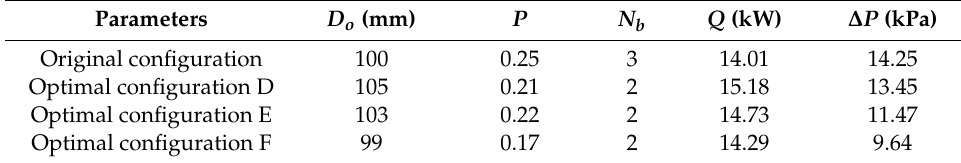
Table 4. Optimization thermohydraulic performances comparison of